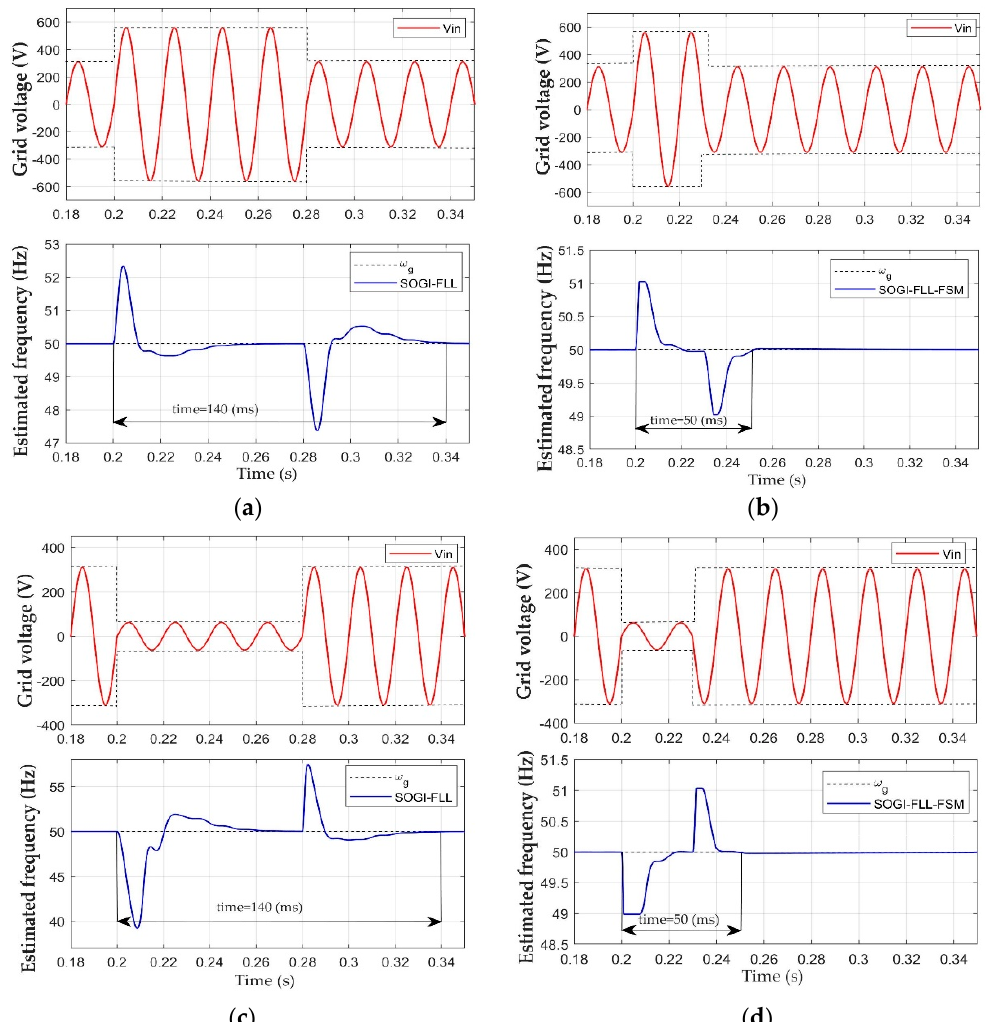
Figure 18. Response of the SOGI-FLL-FSM to short-duration voltage swells and sags. ( a ) and ( b ): 1.8 pu swells at 0.2 s with four and two cycles duration, respectively. ( c ) and ( d ): 0.2 pu sags at 0.2 s with four and two cycles duration, respectively.